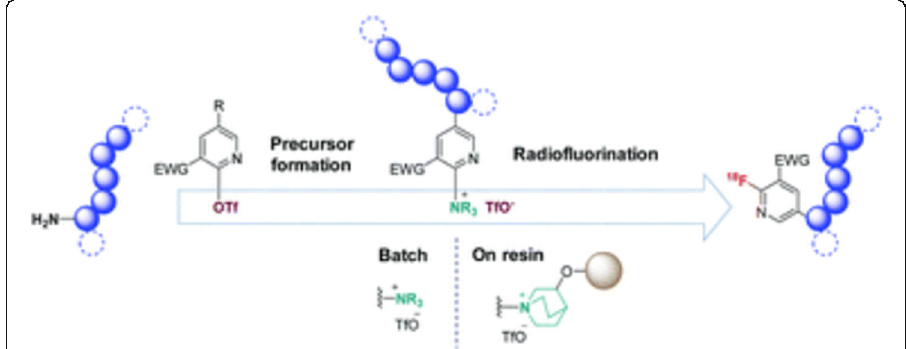
Fig. 9 Resin-based 18 F-radiofluorination for synthesis of [ 18 F]fluoropyridine. This figure was